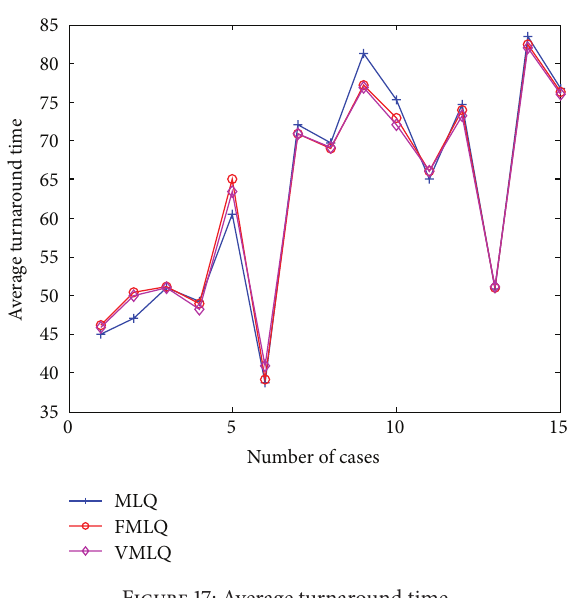
Figure 17: Average turnaround time.